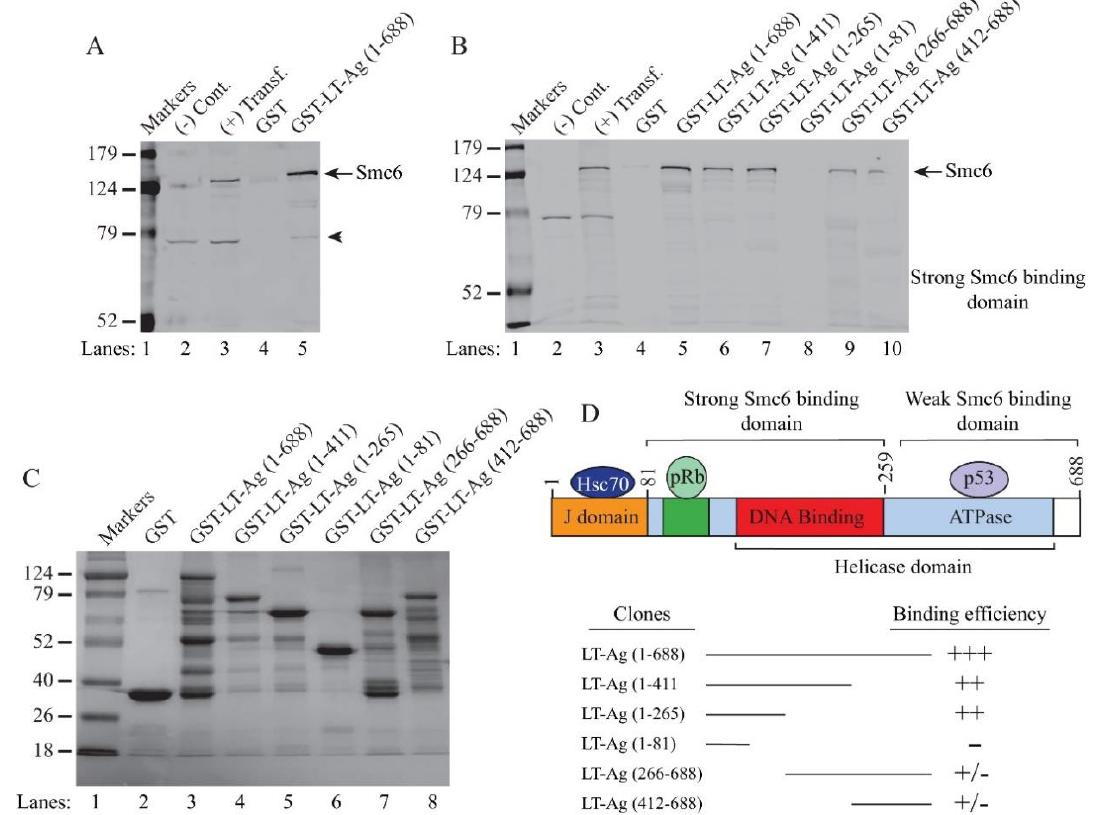
Figure 7. Validation of JCV LT-Ag interaction with Smc6. ( A ) Analysis of the interaction of JCV LT-Ag with Smc6 by GST pull-down assays, as described in the Materials and Methods. Briefly, whole-cell extracts (0.5 mg) prepared from HEK293T cells transfected with the FLAG-tagged-Smc6 expression plasmids (lanes 3 and 5) were incubated with either GST (2 µ g) alone (lane 4) or GST-JCV LT-Ag (2 µ g) (lane 5). After washing, proteins interacting with GST or GST-JCV LT-Ag were analyzed by Western blotting using an α -flag antibody for detecting FLAG-tagged Smc6. ( B ) Mapping the interaction domain(s) of JCV LT-Ag with Smc6 by GST pull-down assays. In parallel to the experiments described for panel A, similar GST pull-down experiments were also carried out for mapping assays, as described in Materials and Methods. Large T antigen-binding proteins were analyzed by Western blotting using an α -flag antibody for detection of FLAG-tagged Smc6. In lanes 2 and 3 (A and B), whole-cell extracts from untransfected [( − ) Cont.] and transfected cells [( + ) transf.] were loaded as negative and positive controls, respectively. ( C ) Analysis of GST, GST-JCV LT-Ag, and GST-JCV LT-Ag mutant proteins by SDS-12% PAGE. GST and GST-JCV LT-Ag and GST-JCV LT-Ag mutants were produced in bacteria and a ffi nity purified, as previously described [73]. Four-microgram aliquots of each protein were resolved on a SDS-12% PAGE and stained by coomassie blue. ( D ) A graphical presentation of LT-Ag domain and the binding e ffi ciency of LT-Ag to Smc6. Binding e ffi ciencies were scaled as +++ : Strong, ++ : Moderate, and +/ − : Weak